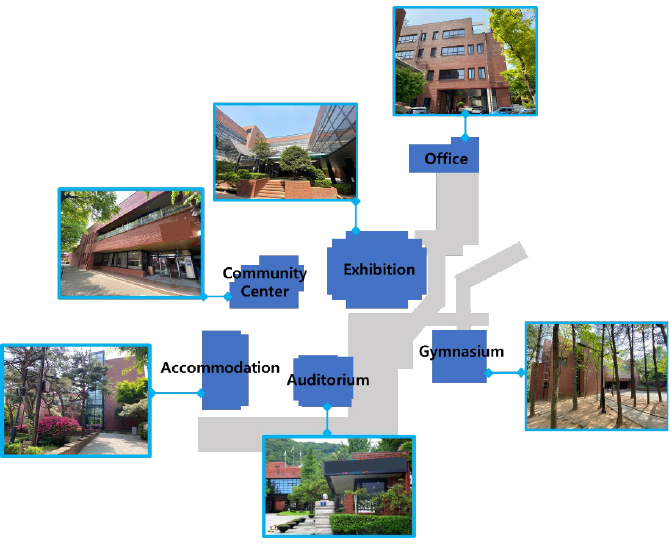
Figure 1. The buildings in the A community.